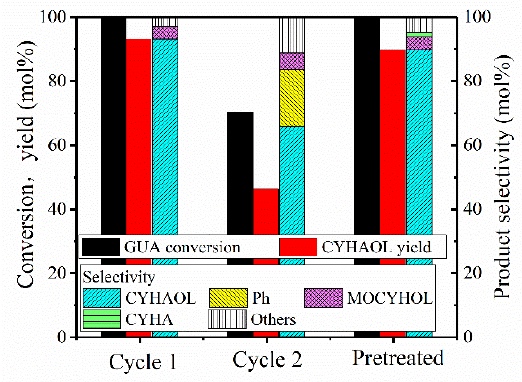
Figure 9. Reuse of Co 2.5 /rGO in HDO of GUA to CYHAOL (reaction conditions: 300 mg of GUA in 10 mL of n-dodecane; catalyst loading = 30 mg; 200 °C; 1 MPa H 2 ; 2 h). 10 mL of n-dodecane; catalyst loading = 30 mg; 200 ◦ C; 1 MPa H 2 ; 2